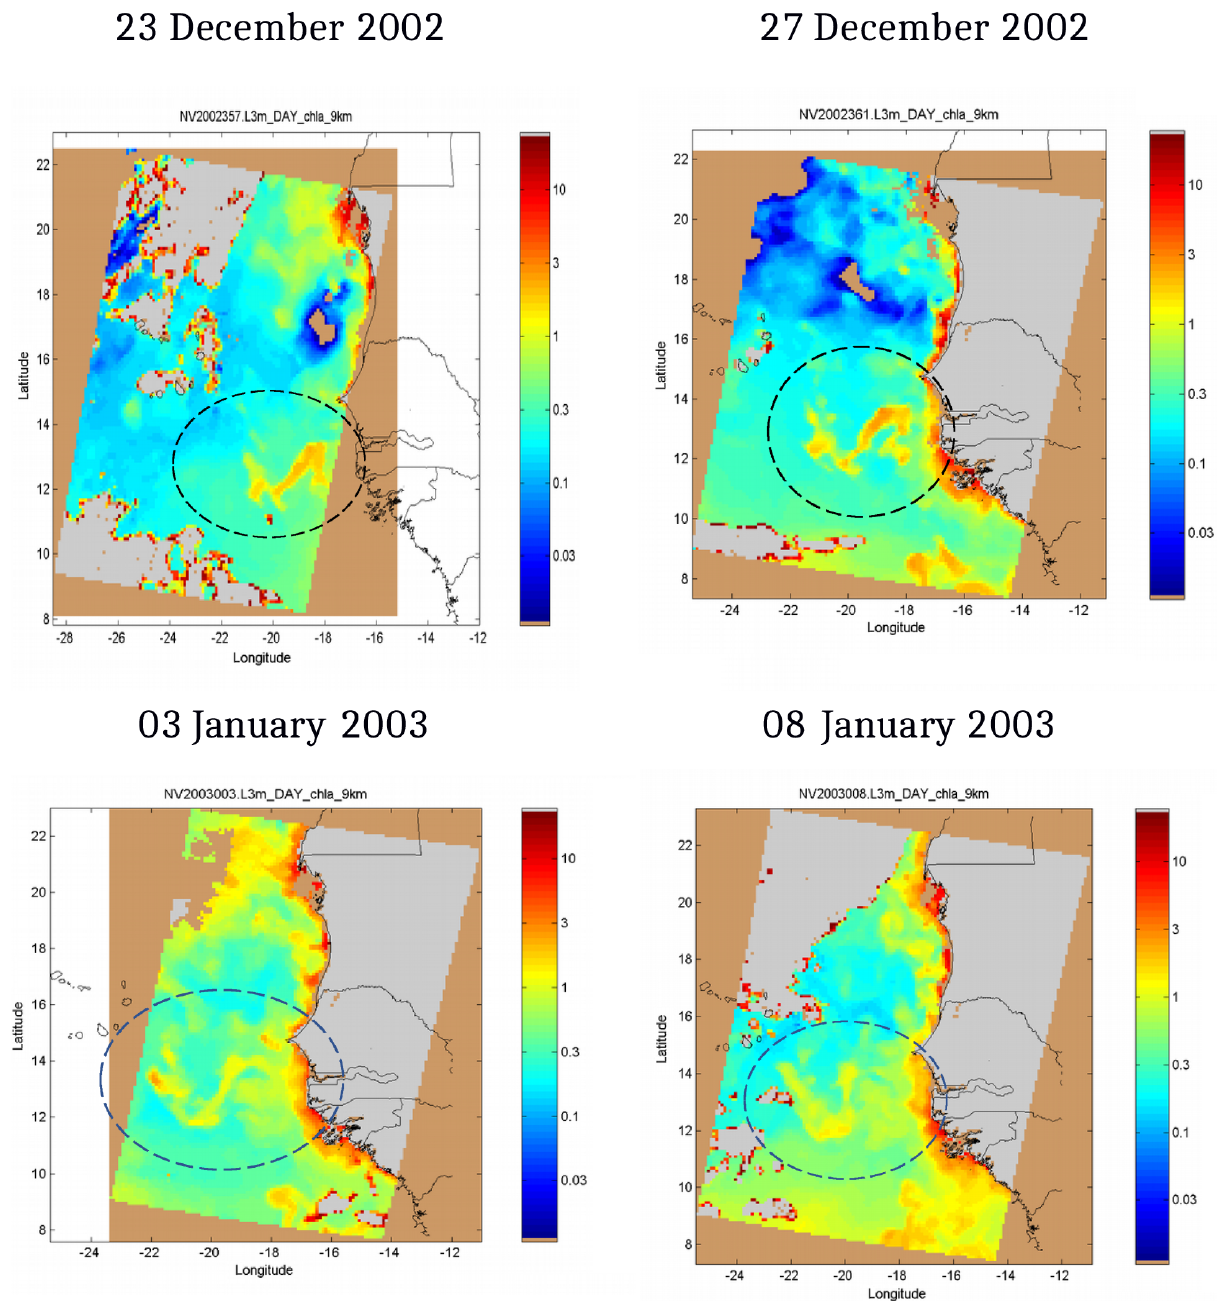
Figure 1. Chlorophyll observed by SeaWiFS at 4 different days. A wave-like pattern (which is circled by a dashed line) is visible between − 22 and − 18 ◦ in longitude and 12 and 14 ◦ in latitude. At the end of the period a westward propagation seems to initiate. The chlorophyll concentration is given in milligrams per cubic metre by the colour bar at the right of the